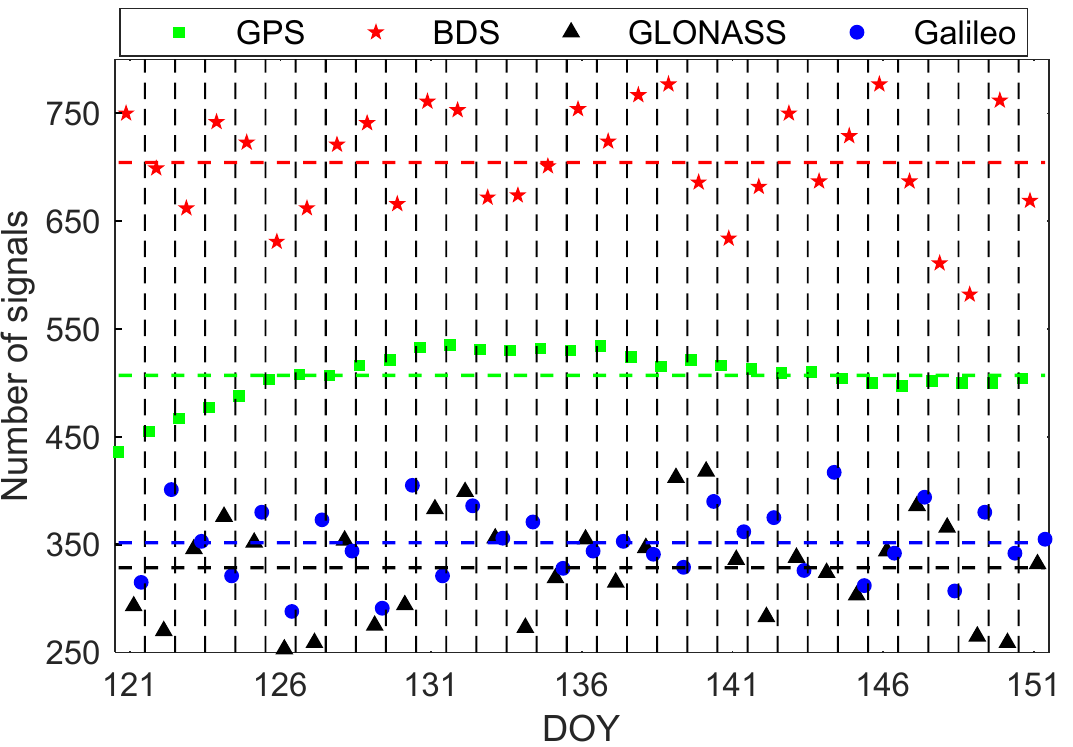
Figure 2. Average number of signal rays used in each solution based on different satellite systems during the experimental period.